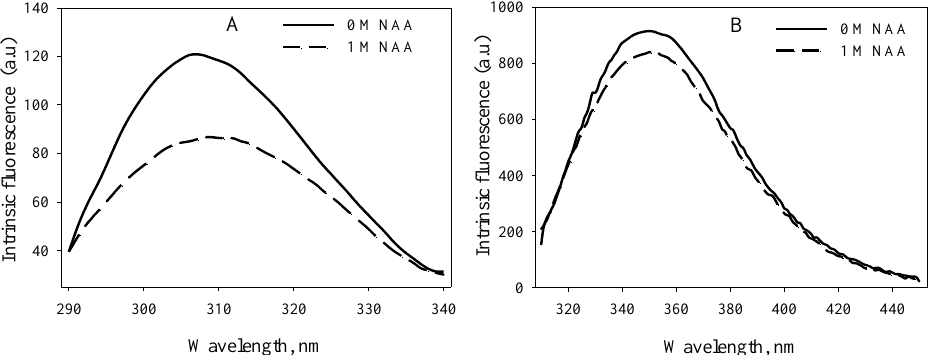
Figure 4. Effect of NAA on the intrinsic fluorescence of native proteins at 25 °C.Tyrosine fluorescence spectra of RNase-A ( A ) and tryptophan fluorescence spectra of lysozyme ( B ) in the absence and presence of NAA at pH 7.0.The protein concentration used was 3 µM.